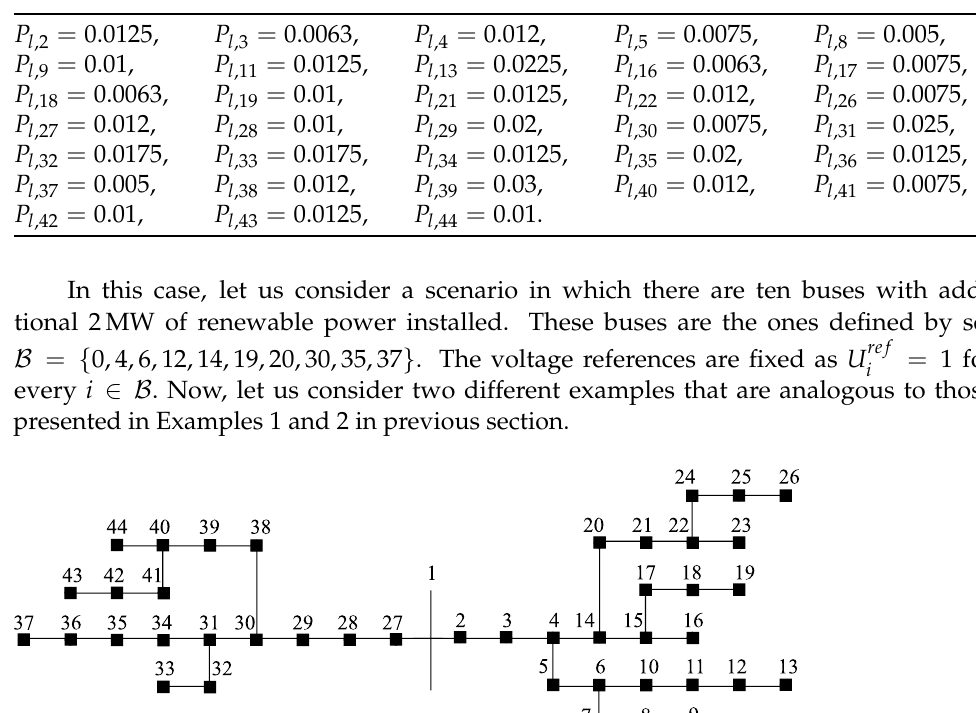
Table 7. Rated power of loads in p.u.